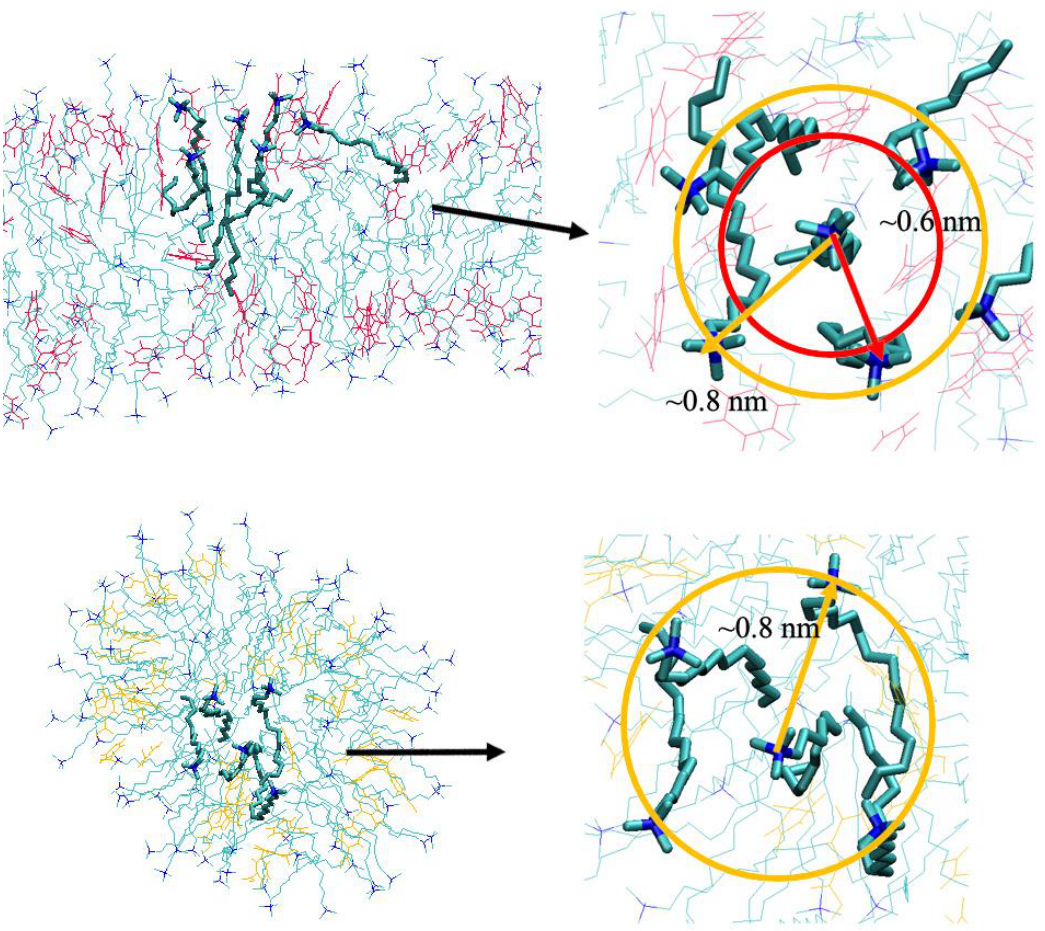
Figure 7. Packed structures of surfactants inside rod-like ( top panel ) and spherical ( bottom panel ) micelles.